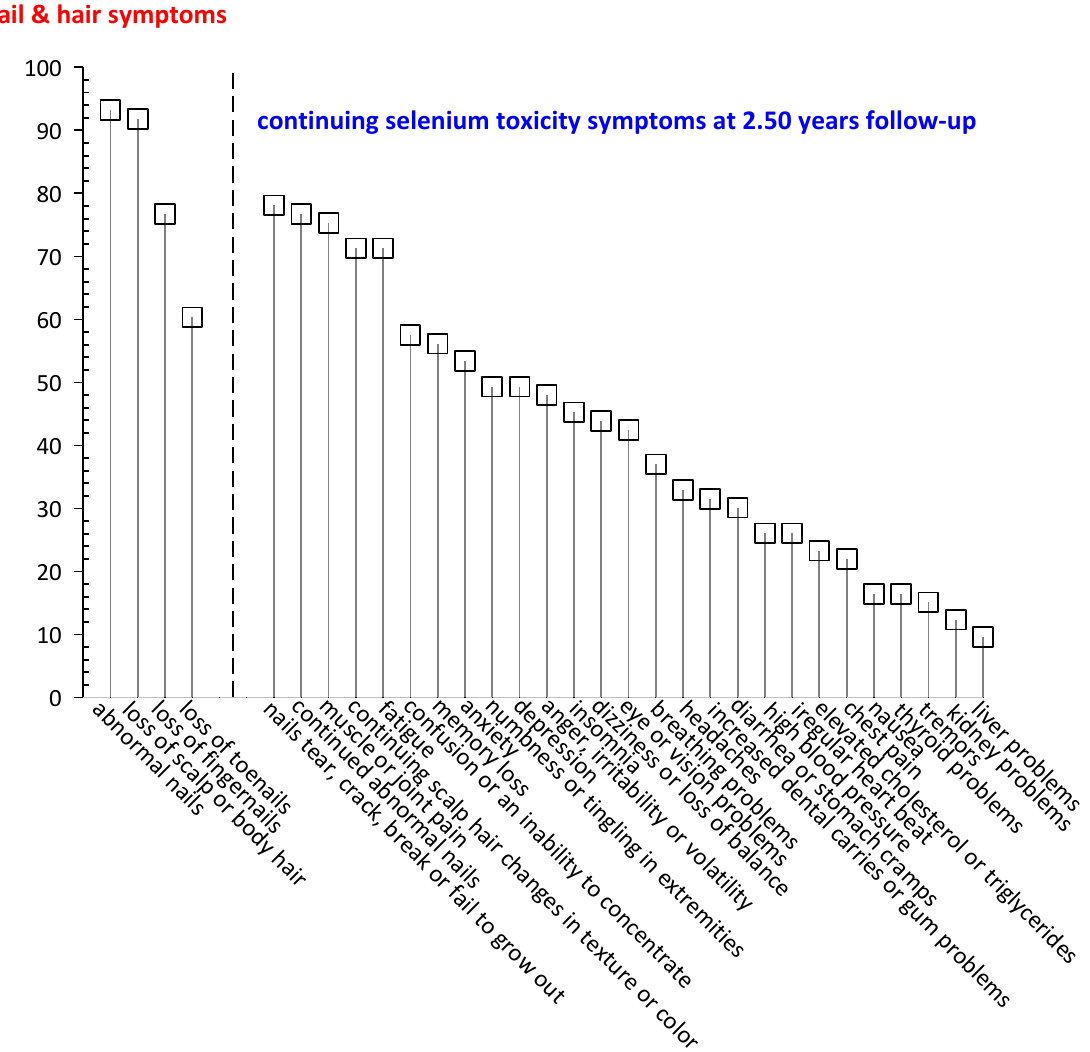
Figure 6. Initial and continuing symptoms of Se toxicity. Seventy-three subjects returned an August 2010 questionnaire inquiring about the impact of their consumption of the misformulated TBF supplement products on their hair and nails and their persistent Se toxicity symptoms. At 2.50 ± 0.14 years follow-up, these 73 subjects reported 1 to 27 persistent symptoms they attributed to Se toxicity; mean = 11.5 ± 6.5; median = 10.